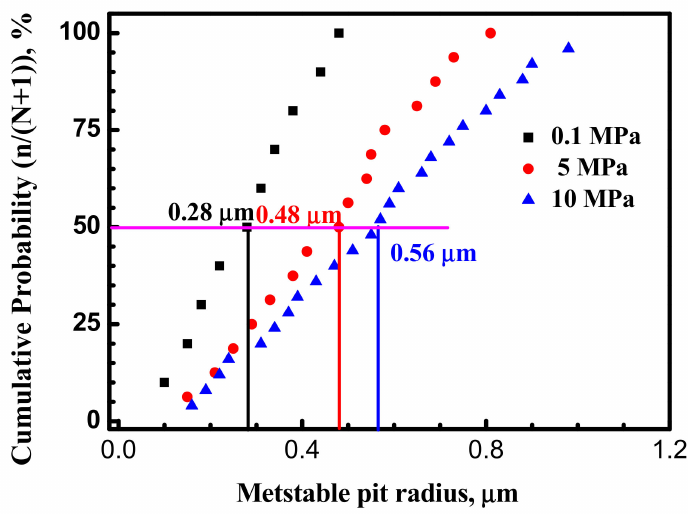
Figure 8. Cumulative distribution of metastable pits radius for the X70 steel at various hydrostatic pressure and − 100 mV vs. Ag/AgCl